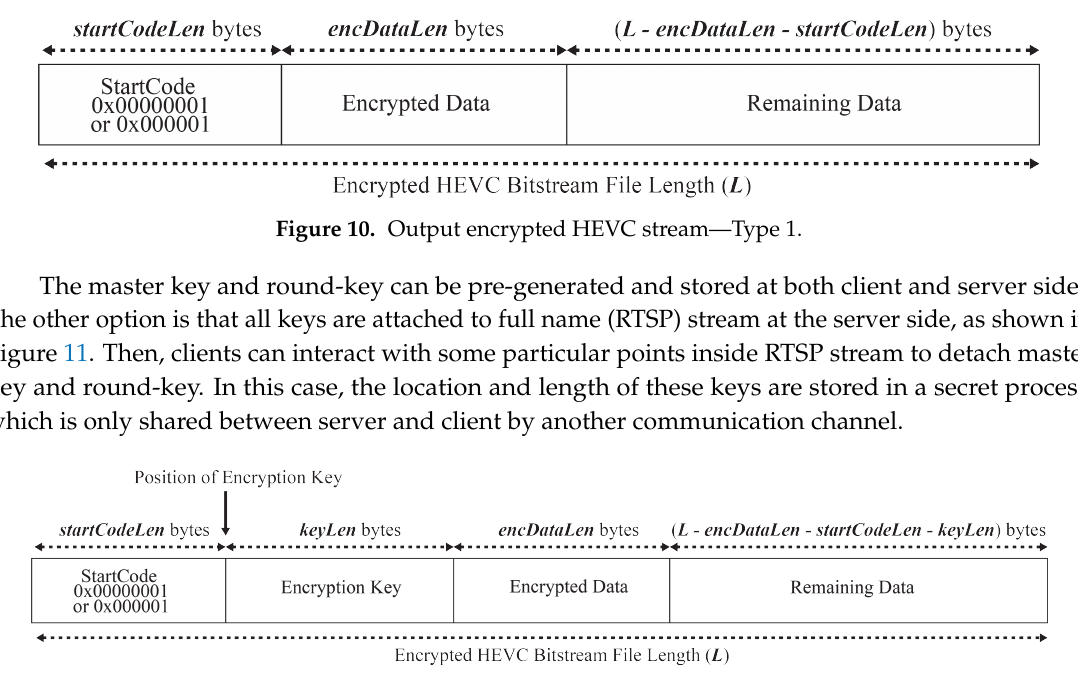
Figure 11. Output encrypted HEVC stream—Type